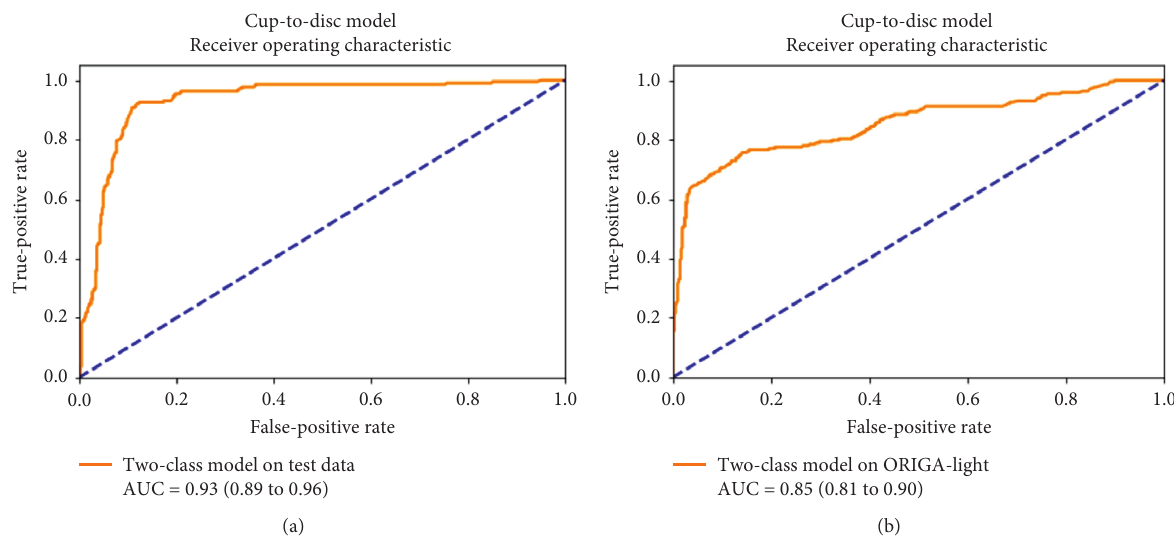
Figure 4: Area under ROC of the test data results (a) and the results for the ORIGA-light dataset (b) for the two-class cup-to-disc ratio model. Table 2: Accuracy, sensitivity, specificity, Cohen’s kappa, and AUC for the system with 95% confidence intervals on the test data and ORIGA-light (validation data), with the ratio over 0.5 considered as a positive case for the model. Measure Test data (with 95% CI) ORIGA-light (with 95%